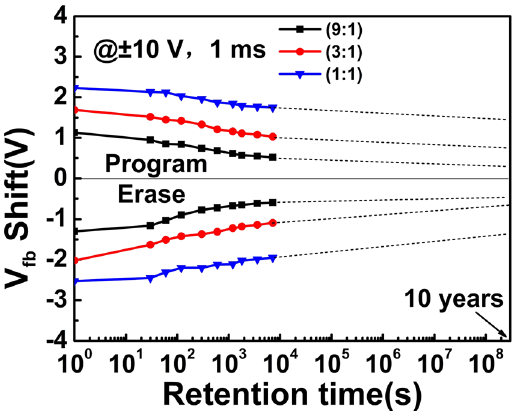
Figure 6. The retention properties of TTO(9:1), TTO(3:1) and TTO(1:1) CTM devices at room temperature.